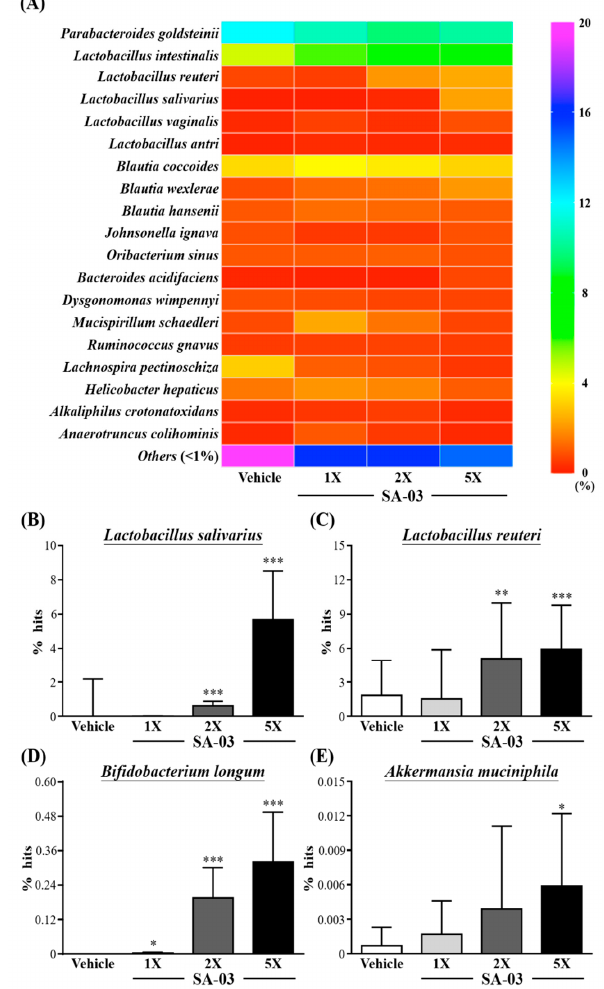
Figure 8. Effect of 4 weeks of SA-03 supplementation on ( A ) Species heatmap of gut microbiota, ( B ) Lactobacillus salivarius % hit, ( C ) Lactobacillus reuteri % hit, ( D ) Bifidobacterium longum % hit and ( E ) Akkermansia muciniphila % hit. Data are expressed as mean ± SD for n = 9 mice per group. Values with different superscript letters are significantly different at *, p < 0.05; **, p < 0.05; ***, p < 0.05 by t - test.